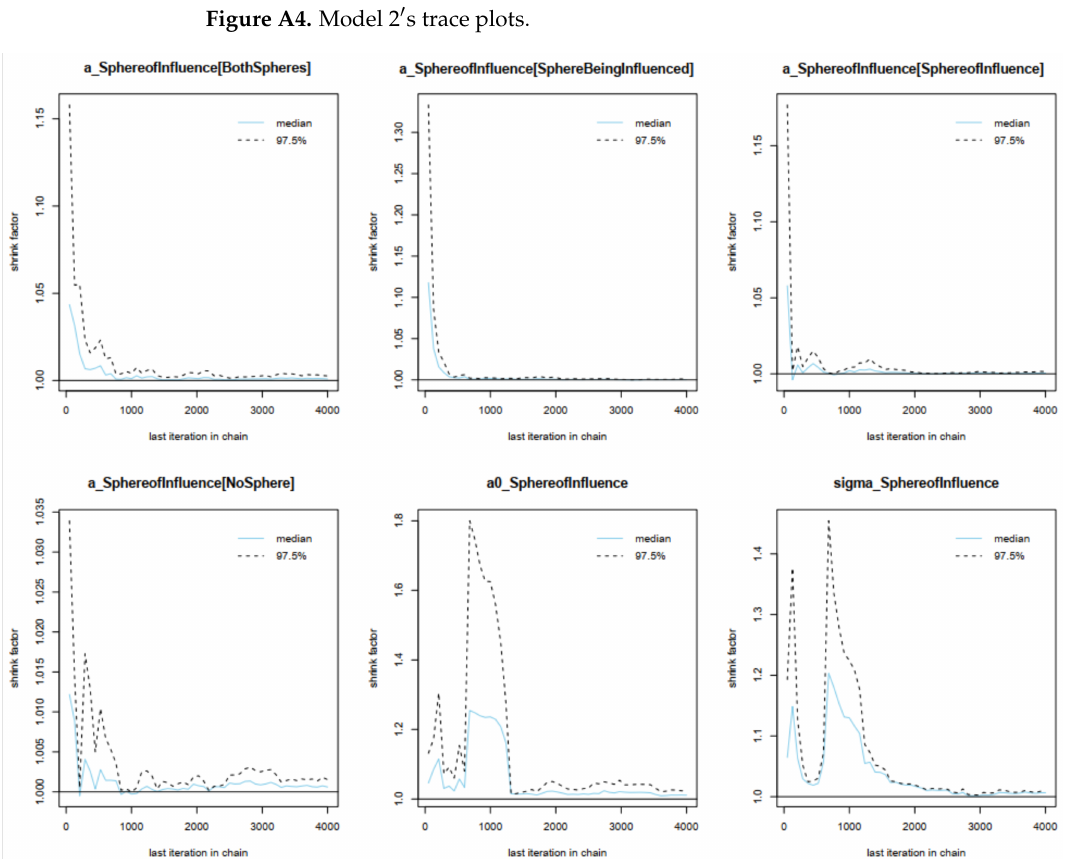
Figure A5. Model 2 (cid:48) Gelman–Rubin–Brook